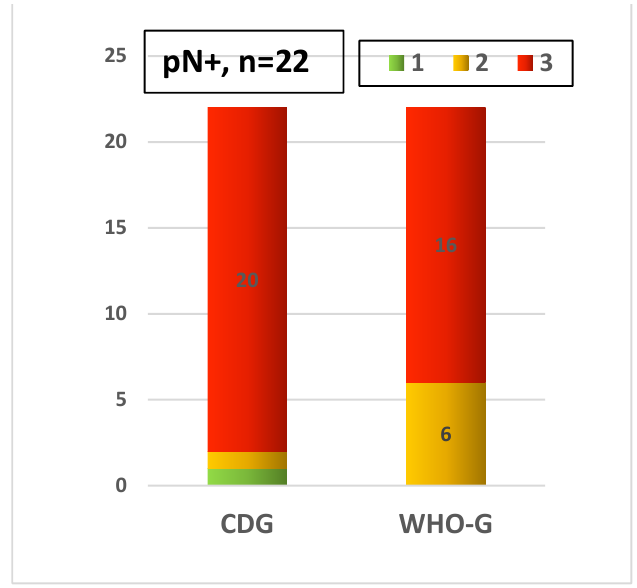
Figure 8. Distribution of both grading systems with pN0 cases.